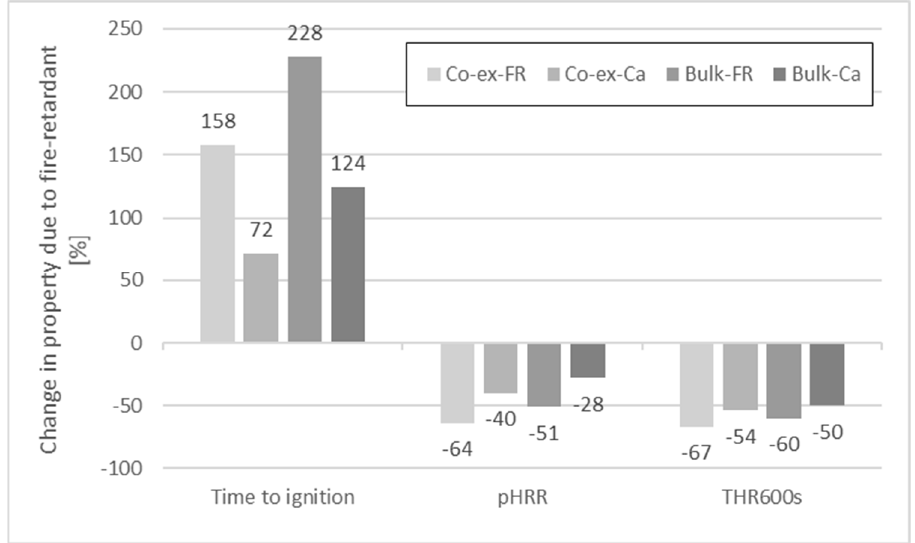
Figure 18. Change in time to ignition, peak heat release rate, and total heat release after 600s due to the fire-retardant (FR CROS 490) or due to calcium carbonate (Ca) in solid profiles (before weathering). FR CROS 490 or Ca were added either in the co-extruded layer or in the bulk of the profiles.